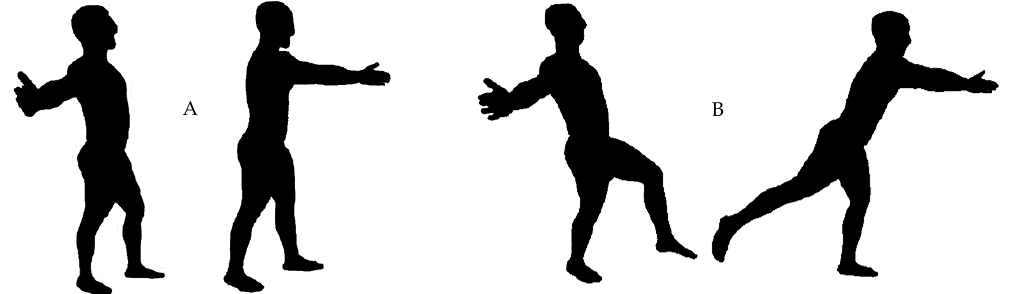
Figure 1. The basic water fitness exercises, “horizontal adduction” ( A ) and “rocking horse” ( B ).